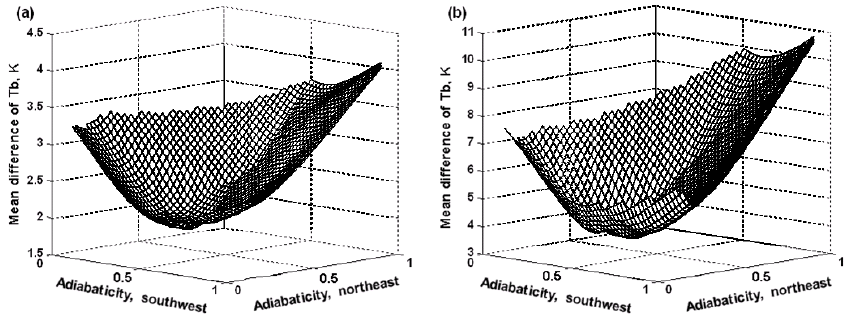
Fig. 11. The mean differences between the calculated and observed brightness temperatures as a function of the adiabaticity of the two regions adjacent to the retrieval domain: (a) for all beams; (b) for beams that pass through either of the two adjacent regions.